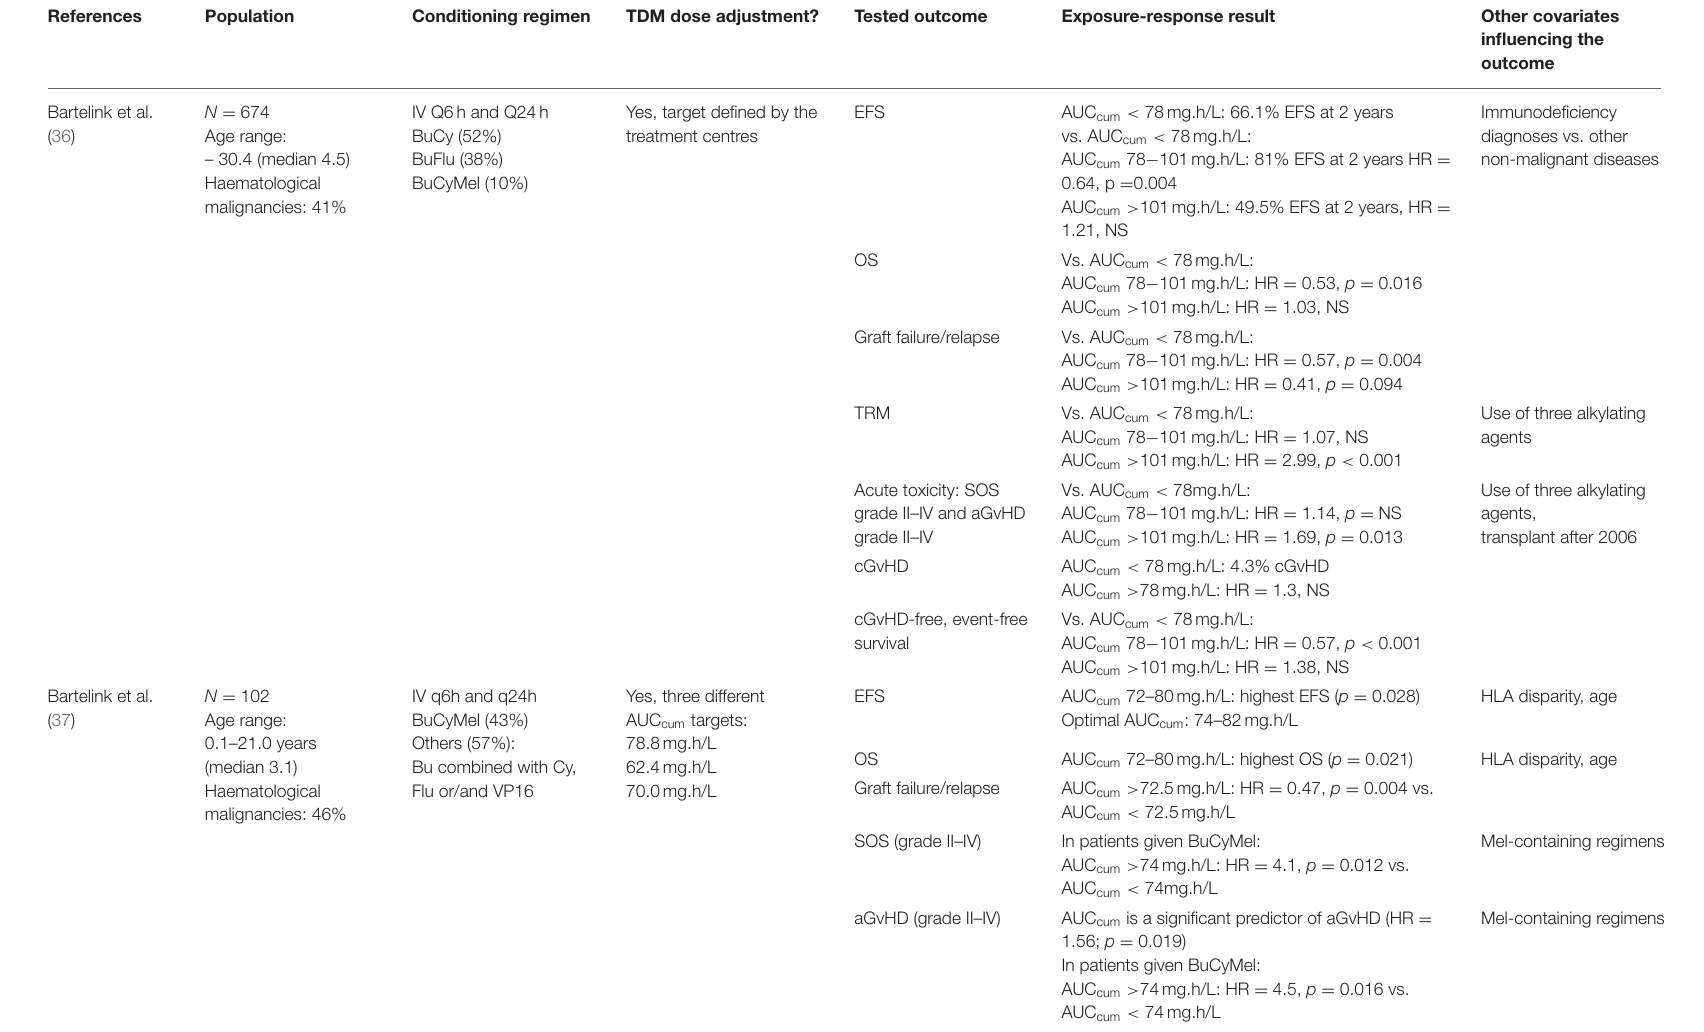
TABLE 1 | Summary of studies assessing exposure response to